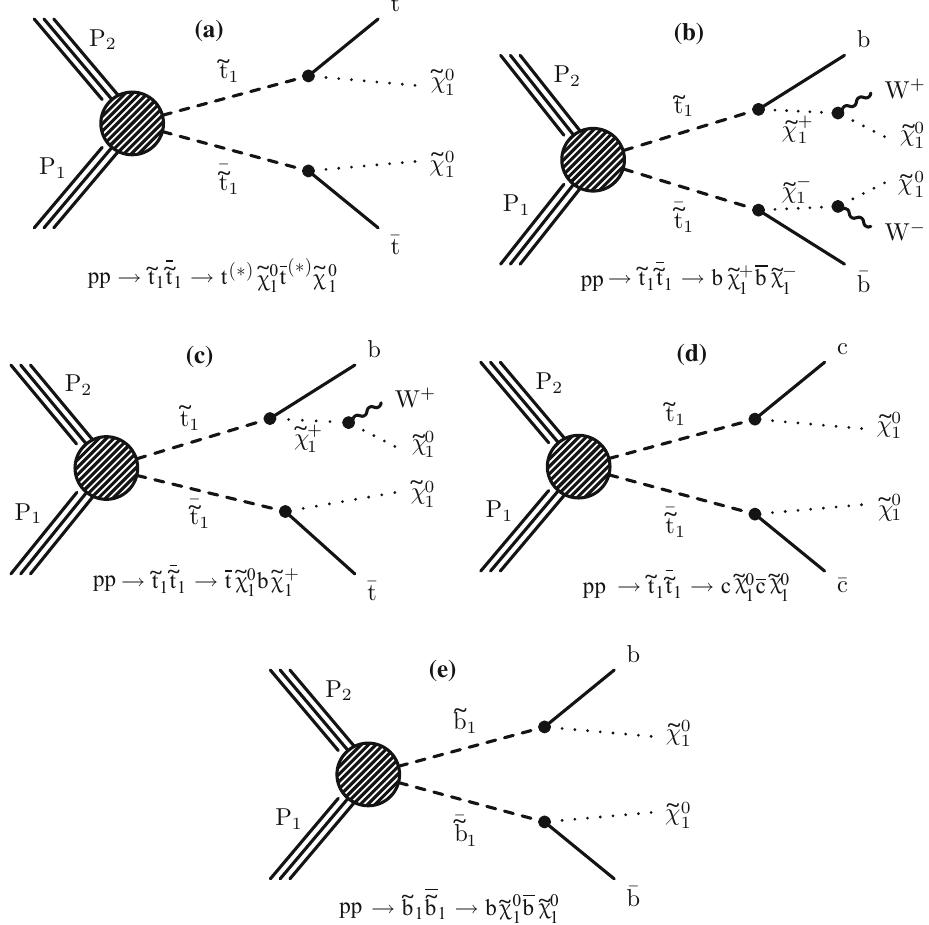
Fig. 1 Feynman diagrams for pair production of top and bottom squarks via the decay modes considered in this paper. The model with 50% branching fractions for (cid:2) t 1 → t ( ∗ ) (cid:2) χ 0